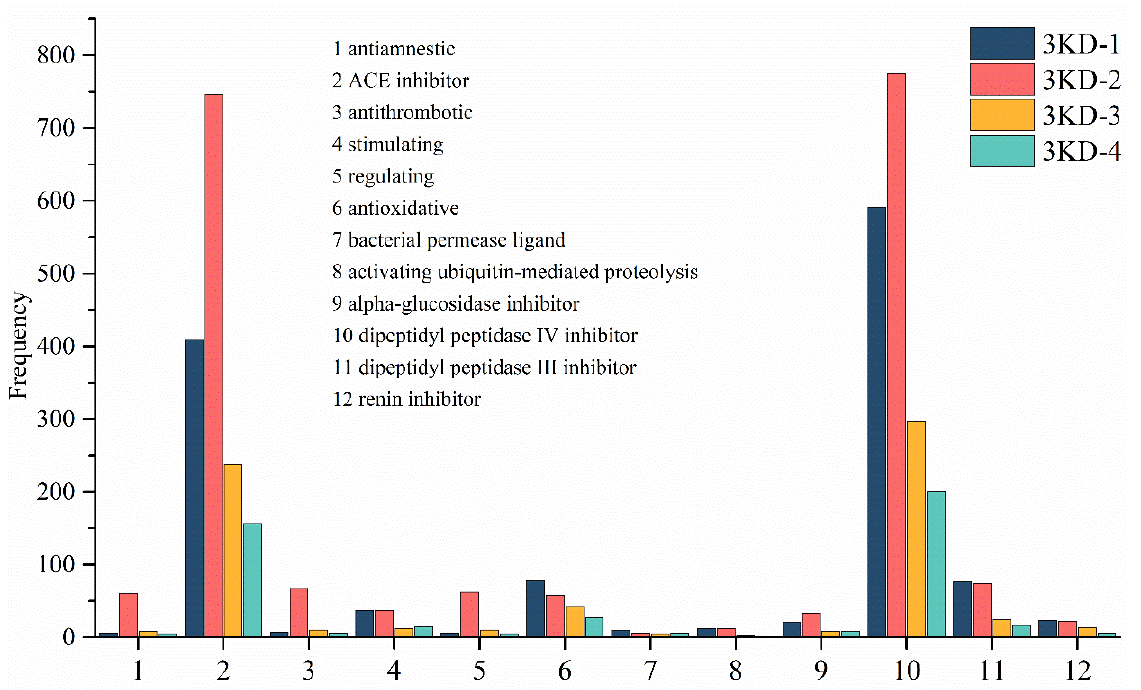
Figure 3. Frequency distribution diagram of the activity prediction results. The vertical axis indicates the frequency of occurrence of the corresponding active fragment, and the horizontal axis indicates the corresponding activity, with each number representing an activity.